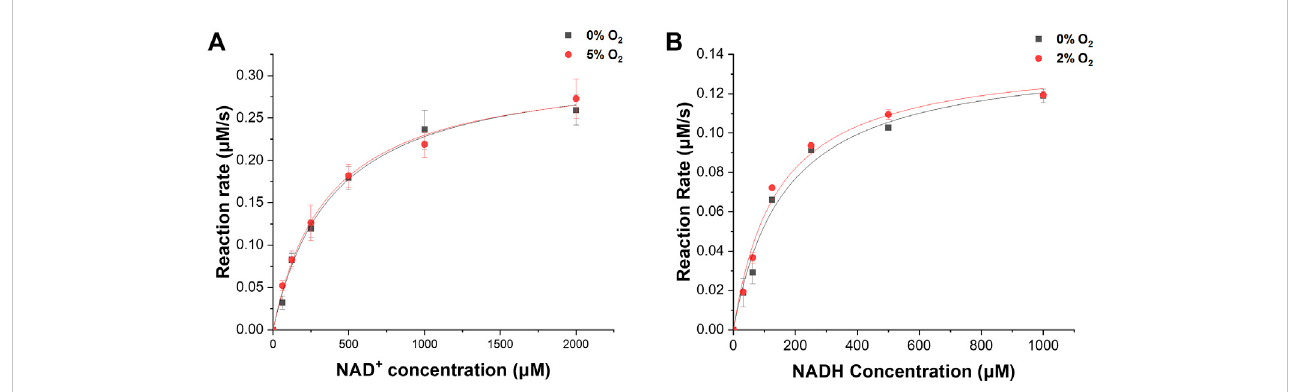
FIGURE 3 Kineticanalysis. (A) NAD + -dependentH 2 oxidationofReSHinthepresenceofO 2 ,ornot. (B) NADH-dependentCO 2 reductionofRcFDHinthepresence of O 2 , or